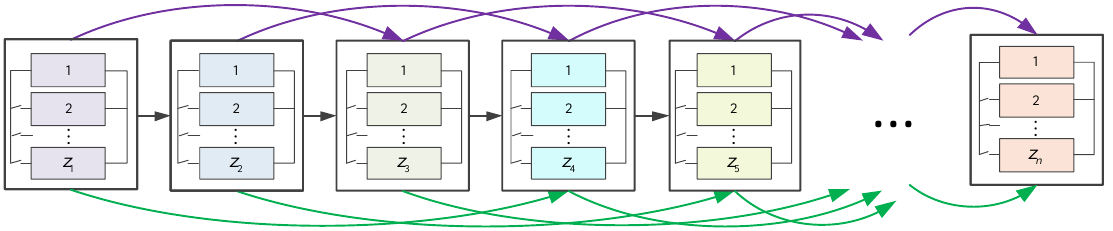
Figure 2. A Lin/Con/ 𝑘 / 𝑛 :F system.